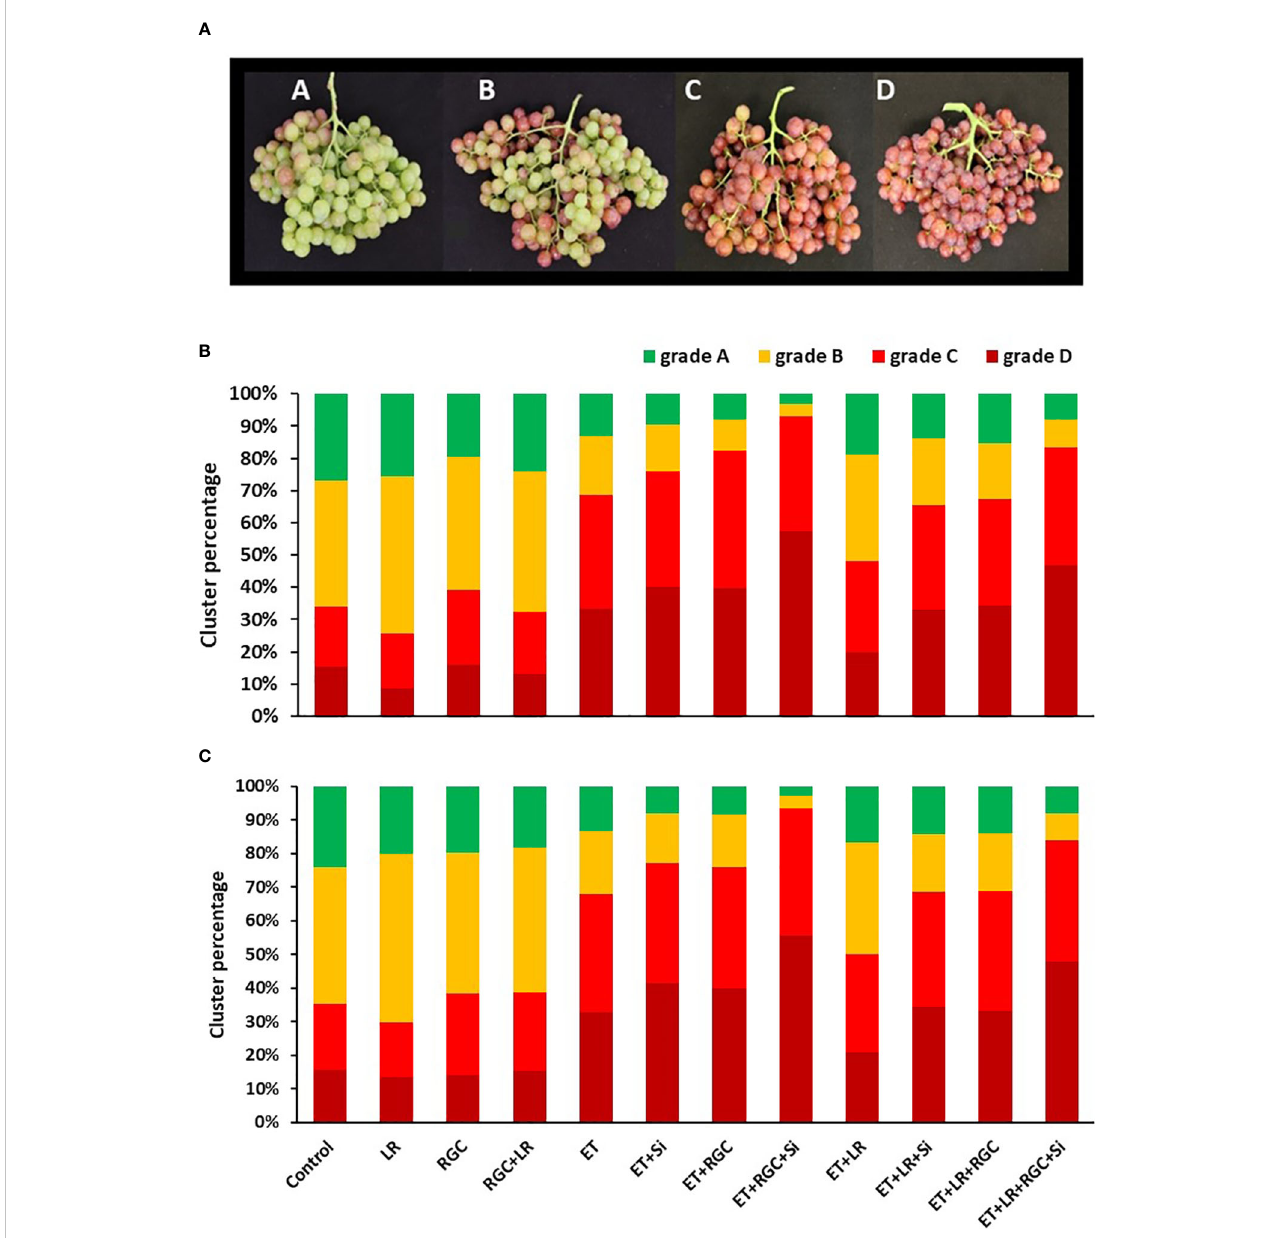
FIGURE 3 Flame Seedless cluster color segregation as affected by the different treatments in 2019 (B) and 2020 (C) . Treatments were: ethephon (ET), silicon 7% (Si), light-re fl ective ground cover (RGC), and their combinations. Treatments have been conducted with or without cluster-zone leaf removal (LR). Different grades used to evaluate Flame Seedless clusters color visually at harvest time. Grades are: A: clusters with less than 25%; B: clusters with 25-50%; C: clusters with 50-75%; and D: clusters with over 75% red-colored berries (A)